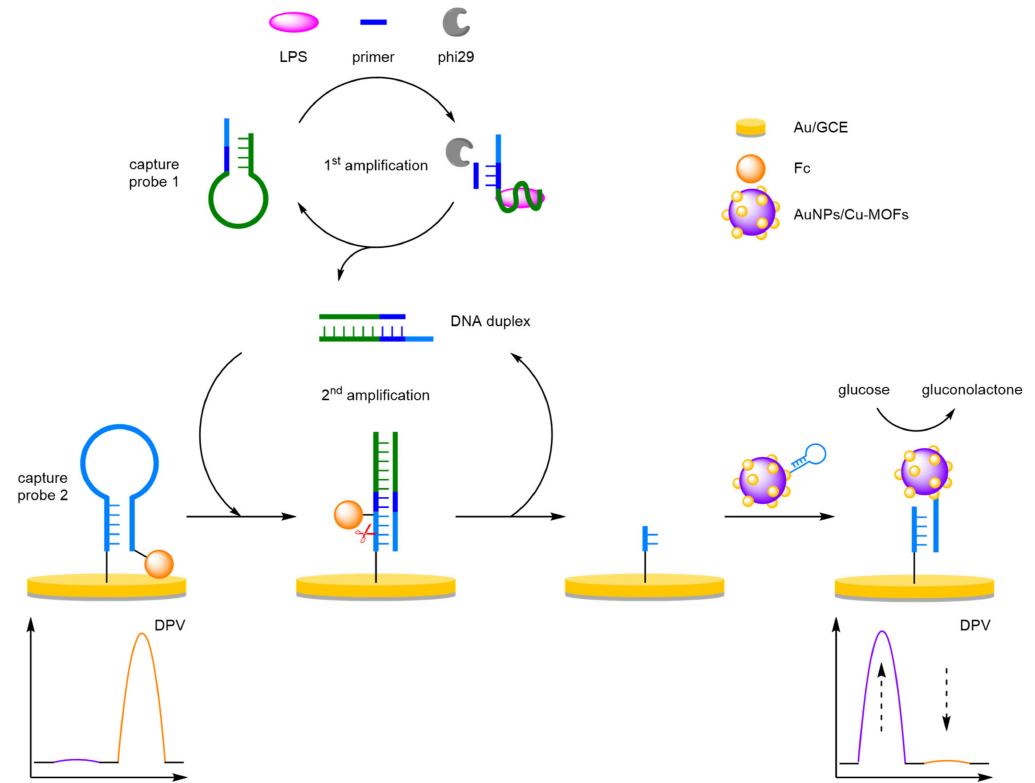
Figure 18. Schematic representation of a catalytic cascade amplified